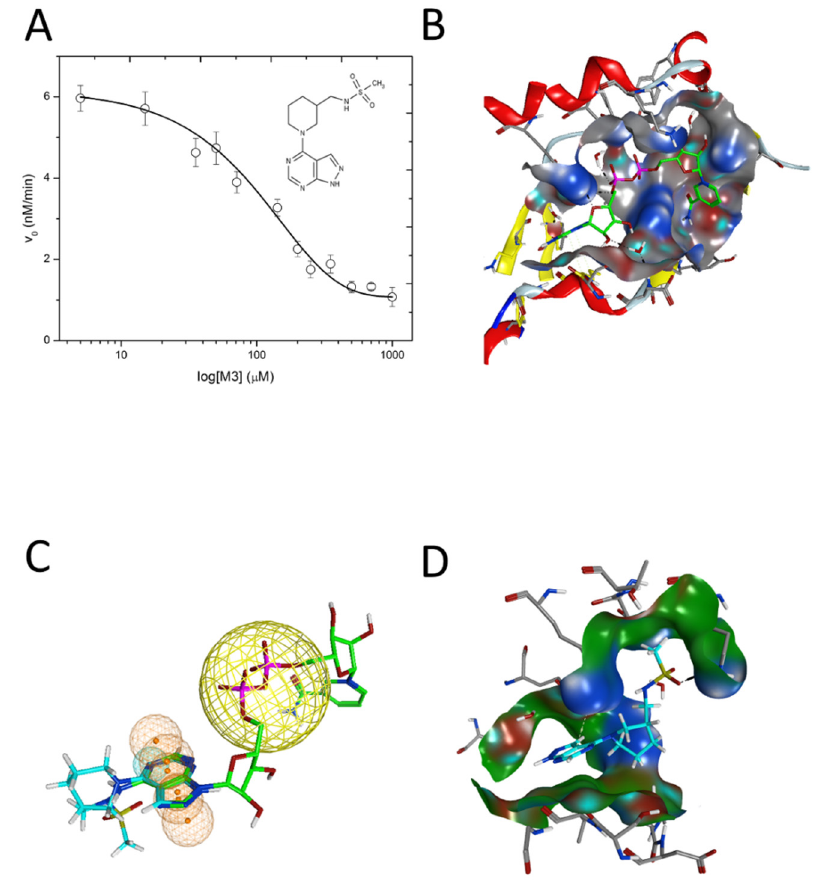
Figure 4. Inhibition of C3larvin GH activity. ( A ) Dose–response curve for the M3 inhibitor on C3larvin activity. Reduction in GH activity upon increasing doses of M3 inhibitor as described in the Materials and Methods section and the IC 50 value was calculated from the data. Error bars, S.D from at least three experiments. Inset to ( A ): M3 inhibitor structure, N -[(1-[1H-pyrazolo[3,4-d]pyrimidin- 4-yl]piperidin-3-yl)methyl]methanesulfonamide. ( B ) C3larvin/Plx2A (gray surface) based on the NAD + active conformation (green C-atoms). ( C ) Pharmacophore model for C3larvin. Modeled active NAD + (green C-atoms) on C3larvin, with M3 (cyan C-atoms) manually superposed with the adenine ring-system, to reveal common features. The orange spheres/mesh show the NAD + adenine pharmacophore definition and the large yellow sphere is an anion-center feature. ( D ) Docked poses of M3 (cyan C-atoms), based on the pharmacophore definition with an induced fit (flexible)